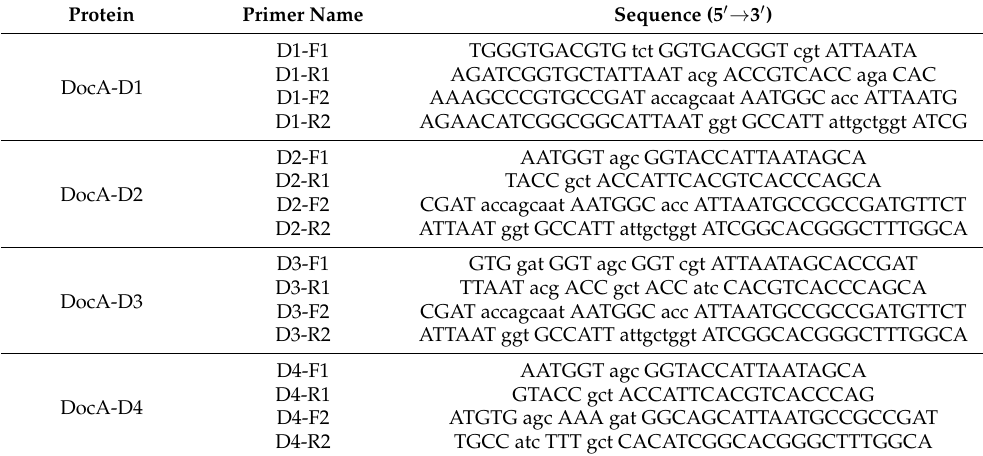
Table 2. The list of double-site mutation primers used in this study.